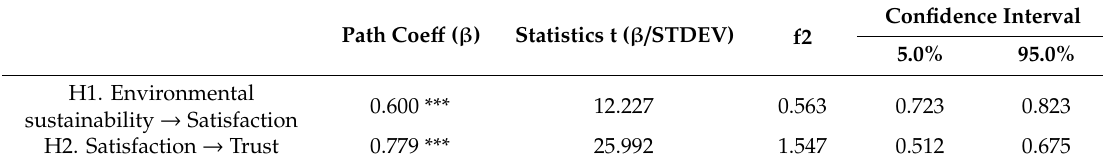
Table 5. Results for Hypotheses